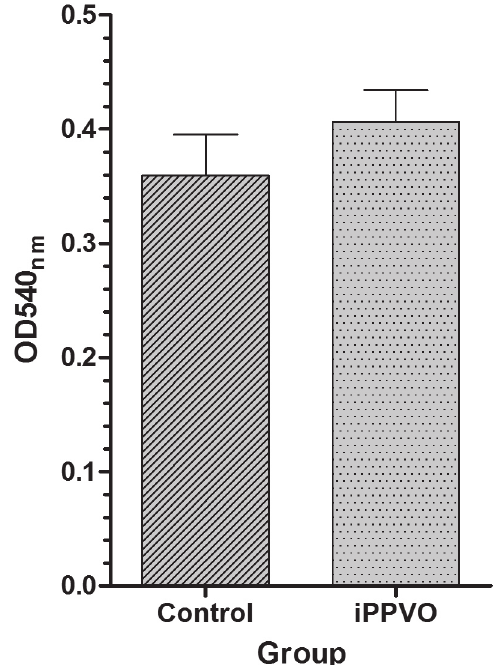
figure 1 - Respiratory burst activity measured on blood cells collected from silver catfish 24 h after inoculation with PBS or iPPVO. Data represent the means ± S.E.M. (n = 15) and were compared using t-test. There were no significant differences (p < 0.05) between